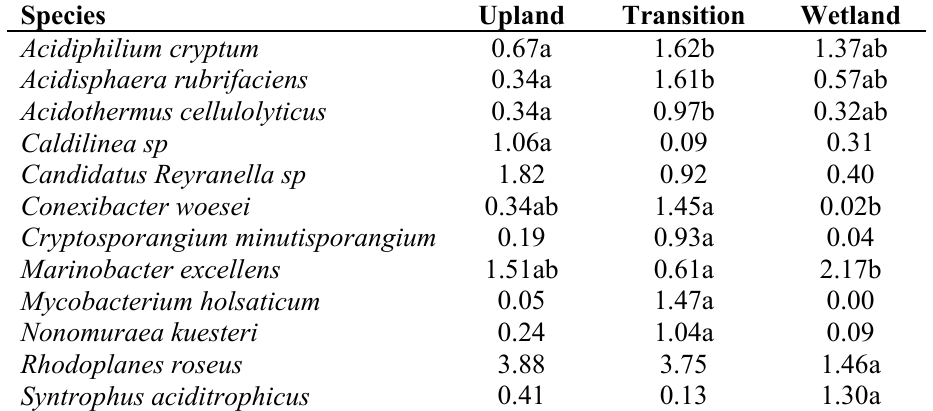
Table 2. A presentation of relative abundance of identified species observed across the study.